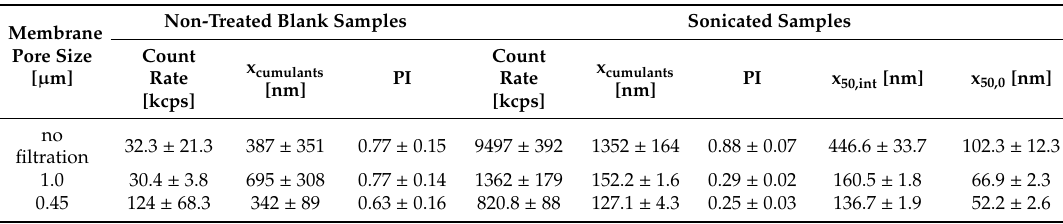
Table 2. Comparison of dynamic light scattering techniques (DLS) results between samples treated with ultrasonic devices and non-treated samples.